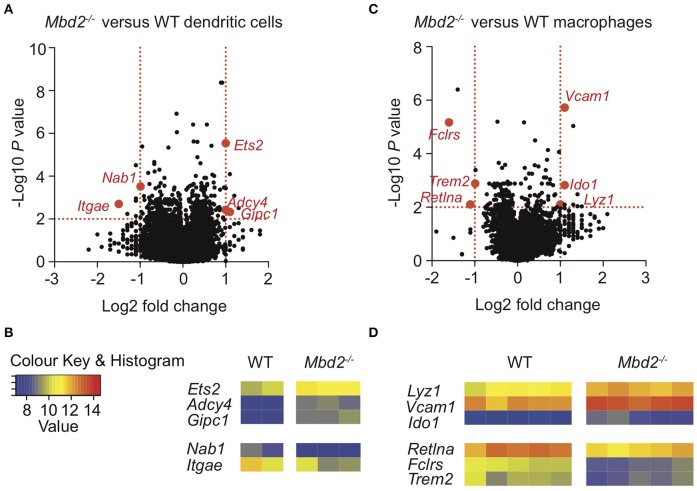
Mbd2 regulates expression of both pro- and anti-inflammatory genes in cDC1 and macrophage populations during colitis. Colon lamina propria cDC1s (CD11c+CD11b−CD103+) (A,B) and macrophages (CD11b+F4/80+MHC-II+Ly6C−) (C,D) were isolated from Mbd2−/− or WT littermate co-housed mice after 6 consecutive days of DSS treatment with RNA extracted for microarray mRNA expression analysis (2–5 biological replicates per genotype). (A,C) Volcano plot depicts differential gene expression profile of Mbd2−/− vs. WT cDC1s (A) or macrophages (C), with selected genes highlighted in red. Dashed lines represent P < 0.05, and ±1-fold change. (B,D) Heat map of relative gene expression values from those highlighted loci in (A,C) (log2 normalized intensity, one-fold change-filtered, P < 0.05).